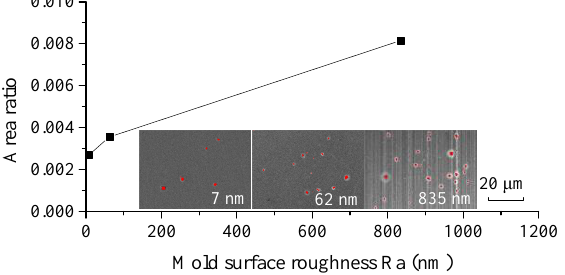
Figure 18. Area ratios of the microdimples of the formed ChG pillars with different mold surface roughness values under the pressure force of 4085 N at 382 °C.